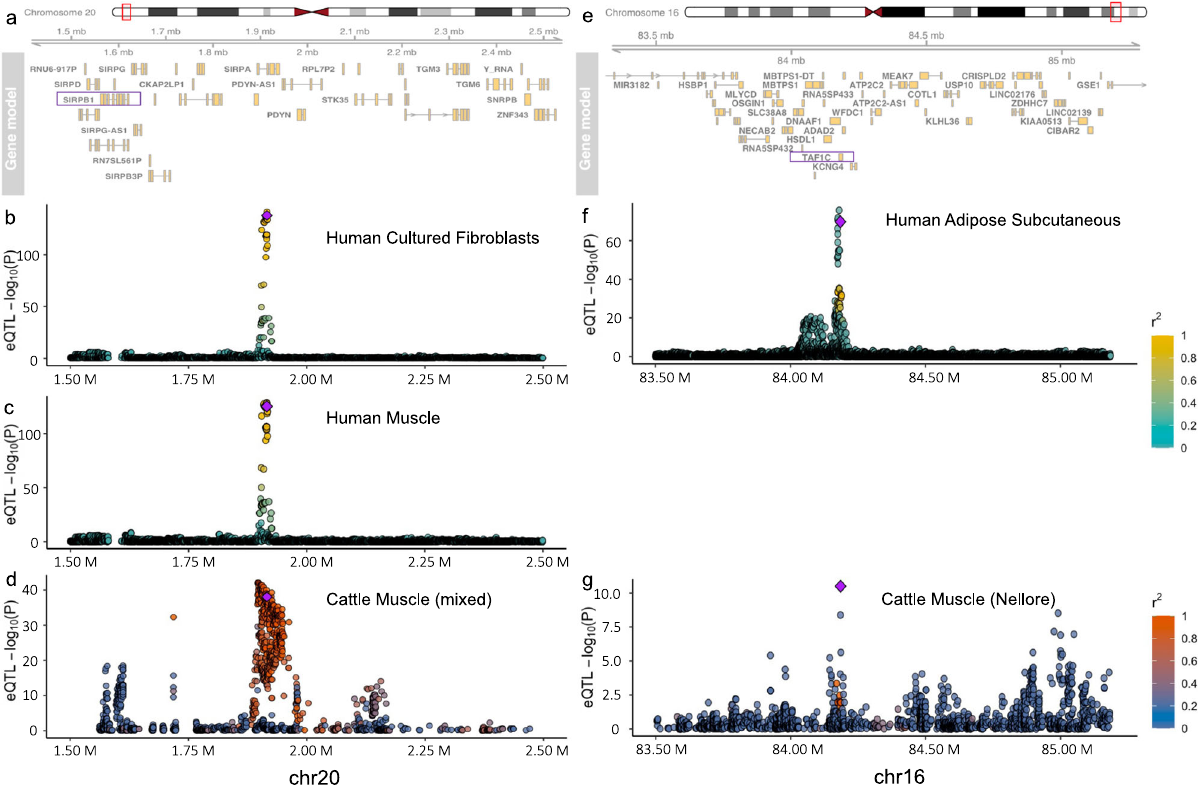
Fig. 7 Colocalization of eQTLs across humans and cattle. a The human gene neighborhood (hg38) of a shared eQTL, rs115287948, found across both humans and cattle. The gene regulated by the eQTL is indicated by a purple rectangle. b Strength of association of human variants with SIRPB1 expression levels in cultured fi broblasts tissue. The fi ne-mapped regulatory variant, rs115287948, with a cattle orthologue is represented by the purple diamond. Other variants are colored according to their linkage disequilibrium ( r 2 ) with this variant. c Strength of association of the same human variants but in muscle tissue. d Strength of association of variants with SIRPB1 in cattle muscle tissue (mixed breeds). Each variant is plotted according to their orthologous position in the human genome and the variant with a fi ne-mapped orthologue in the human GTEx data is represented by the purple diamond. e – g same as a , b , d but for variant rs2230126 linked to the expression of TAF1C in different tissues. The data underlying this fi gure can be found in Supplementary Data